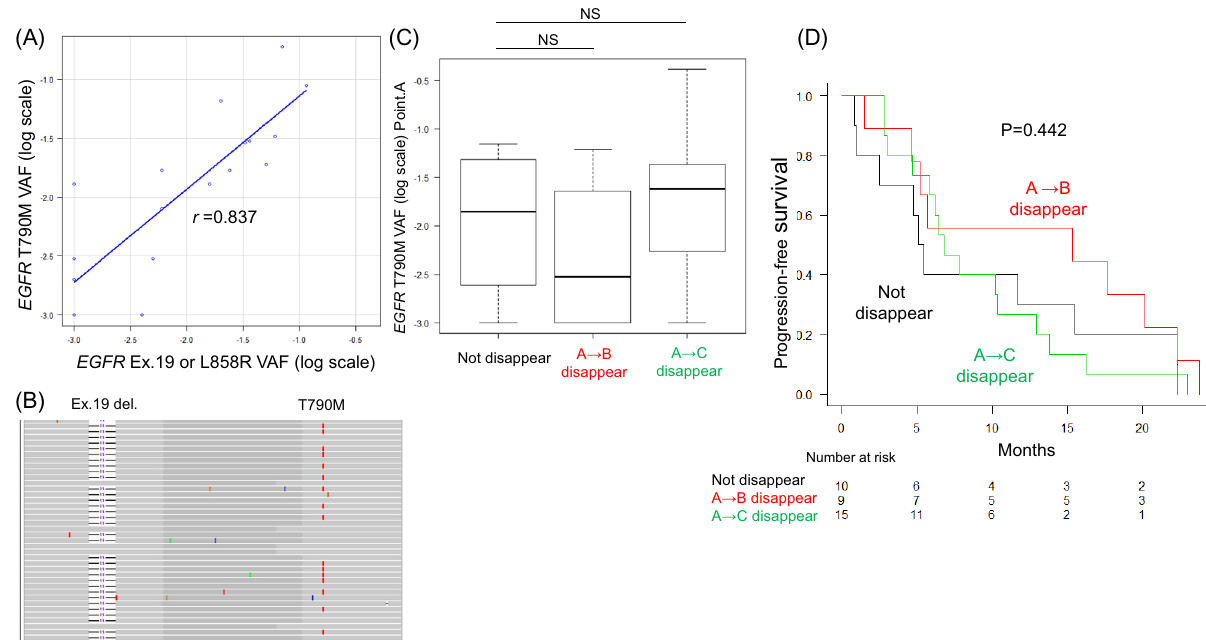
Figure 2. ( A ) A scatterplot graph and correlation analysis (r = 0.837) results for VAF of the EGFR Ex.19 deletion or L858R mutations (X axis) and the EGFR T790M mutations (Y axis) ( B ) The cis–trans configuration between the activating and resistance mutations was analyzed by target RNA-Seq analysis of tissue biopsy specimens. This figure shows an example of a cis pattern of Ex.19 deletion and T790M visualized by the IGV genome browser. The region bridging Ex.19 and Ex.20 of EGFR was amplified by RT-PCR and the amplicon was sequenced by NGS. Most sequencing reads with a 15-bp Ex.19 deletion (represented by the blue line and number) harbor T790M mutations on the same RNA molecule. ( C ) Comparison of the VAF of EGFR T790M at point A between the no disappearance, A → B disappearance, and A → C disappearance groups. NS; no significance. ( D ) Kaplan–Meier plot of PFS for osimertinib treatment. Comparison of PFS between the no disappearance, A → B disappearance, and A → C disappearance groups ( p =